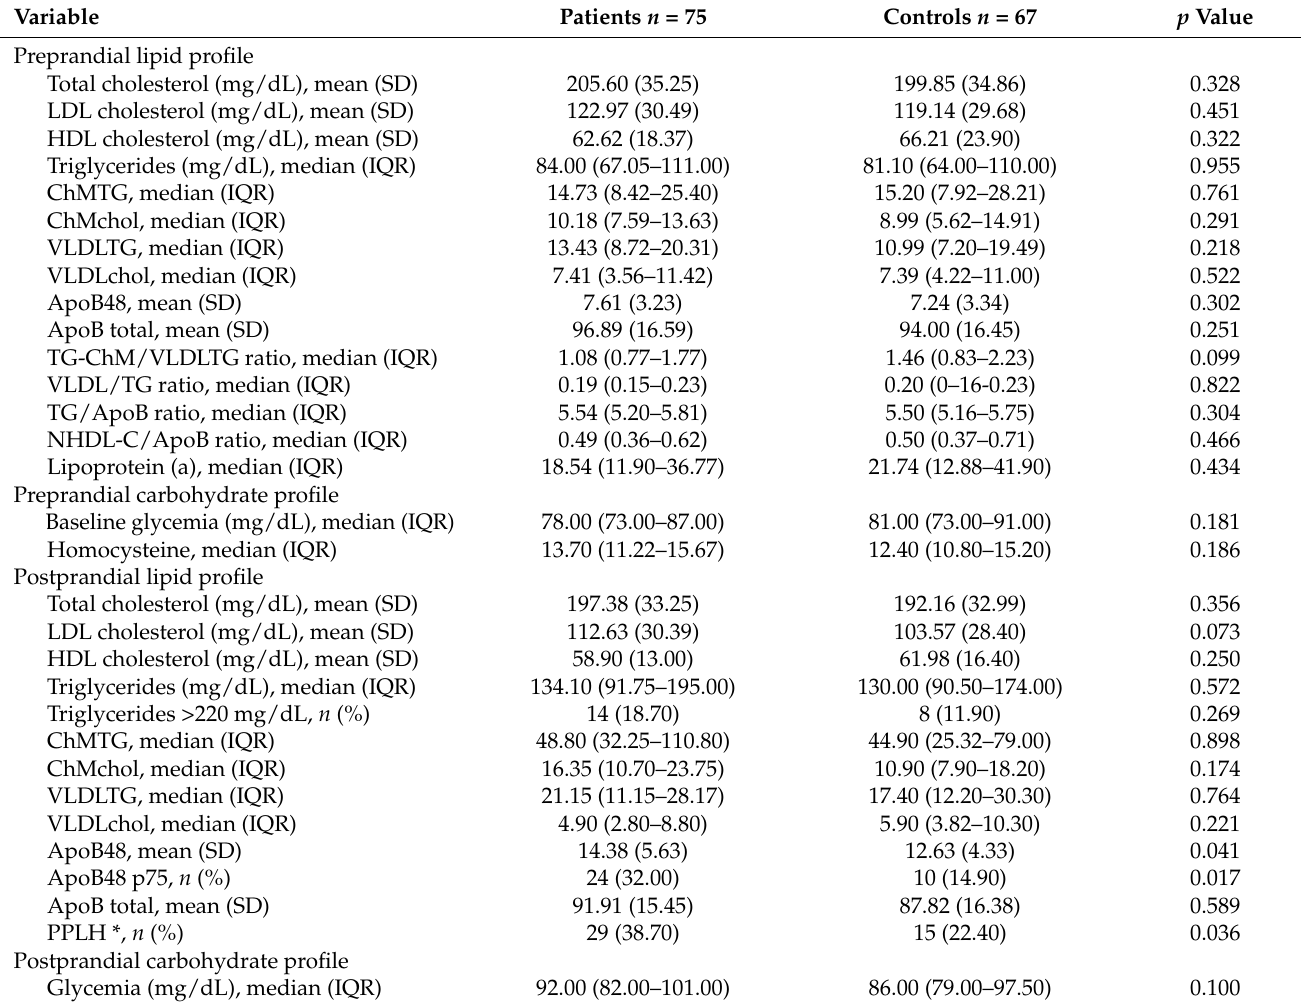
Table 3. Lipid profile for 75 patients with RA and 67